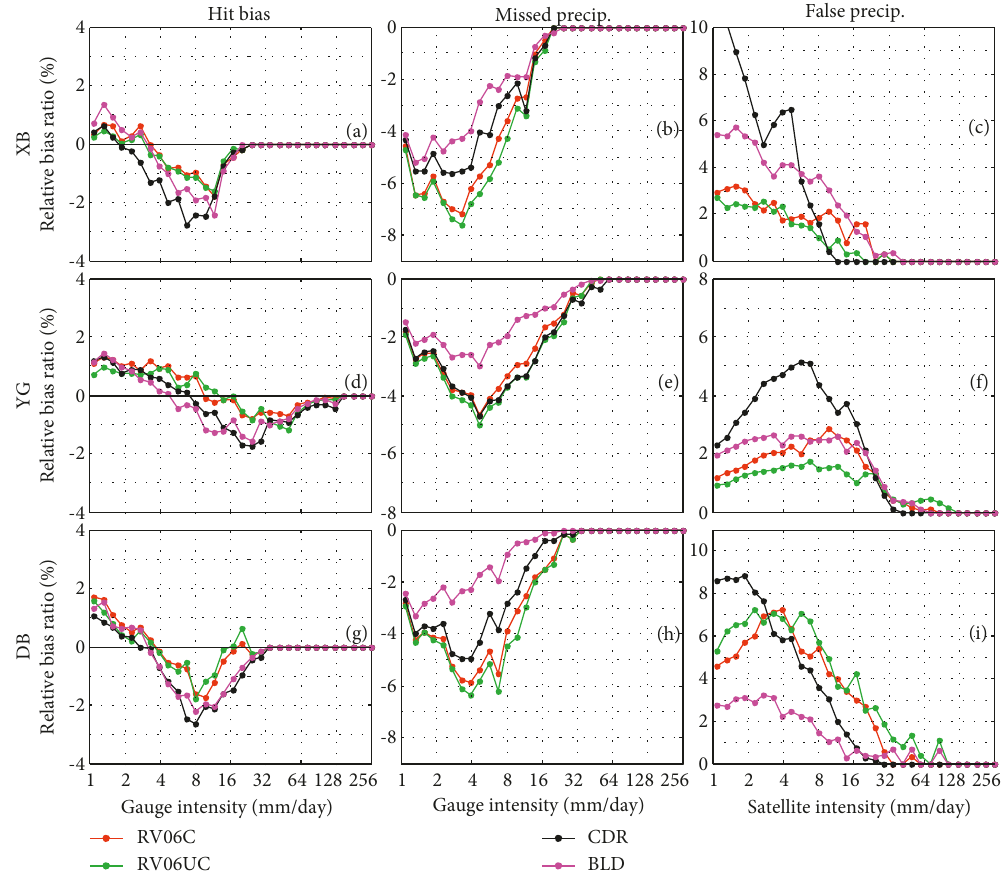
Figure 22: Same as Figure 19, but for winter